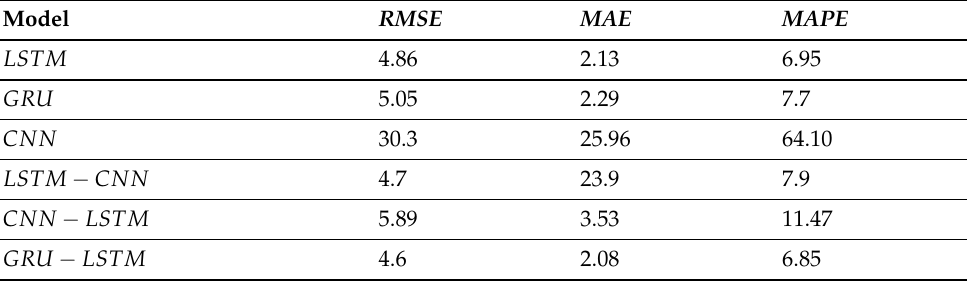
Figure 7. Evaluation metrics of prediction on test data. Table 4. Performance metrics of deep learning